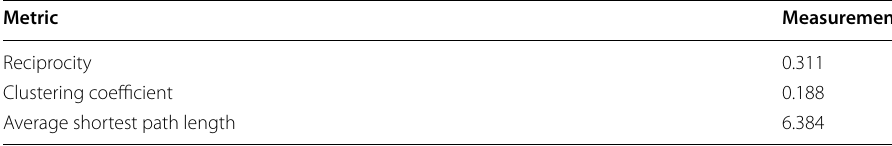
Table 5 Structural metrics of the MACN